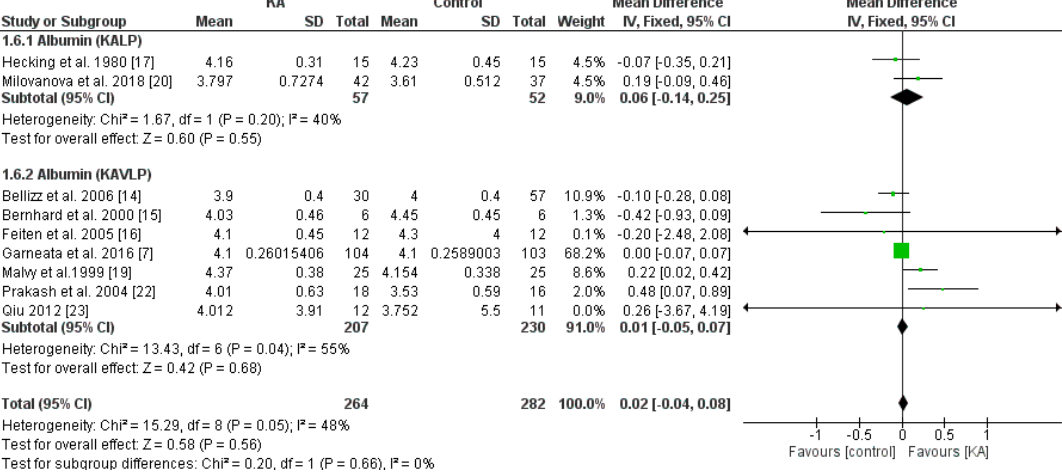
Figure 8. Forest plot of effects of KA on serum albumin in patients sub-grouped by the type of restricted protein diet. The random-effects model was utilized. KAVLP: very-low-protein diet supplemented with ketoanalogues. KALP: low-protein diet supplemented with ketoanalogues. LP: low-protein diet.